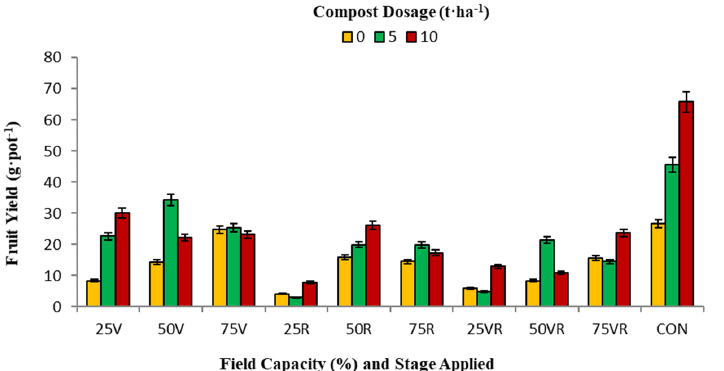
Figure 10. Effect of interaction of water regime, treatment stage and compost dosage on fruit yield of okra The 25, 50 and 75% represent field capacity; V (vegetative), R (reproductive), and VR (vegetative and reproductive) represent the stage at which the deficit was applied. Data in the interaction analysed with Least Squares Means, and means separated with LSD.